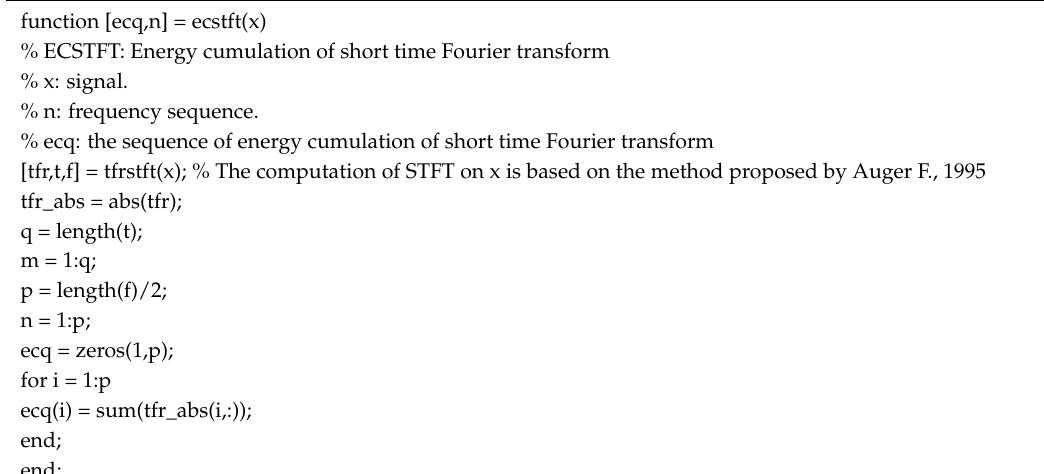
Algorithm A1. Matlab Code of Computation on